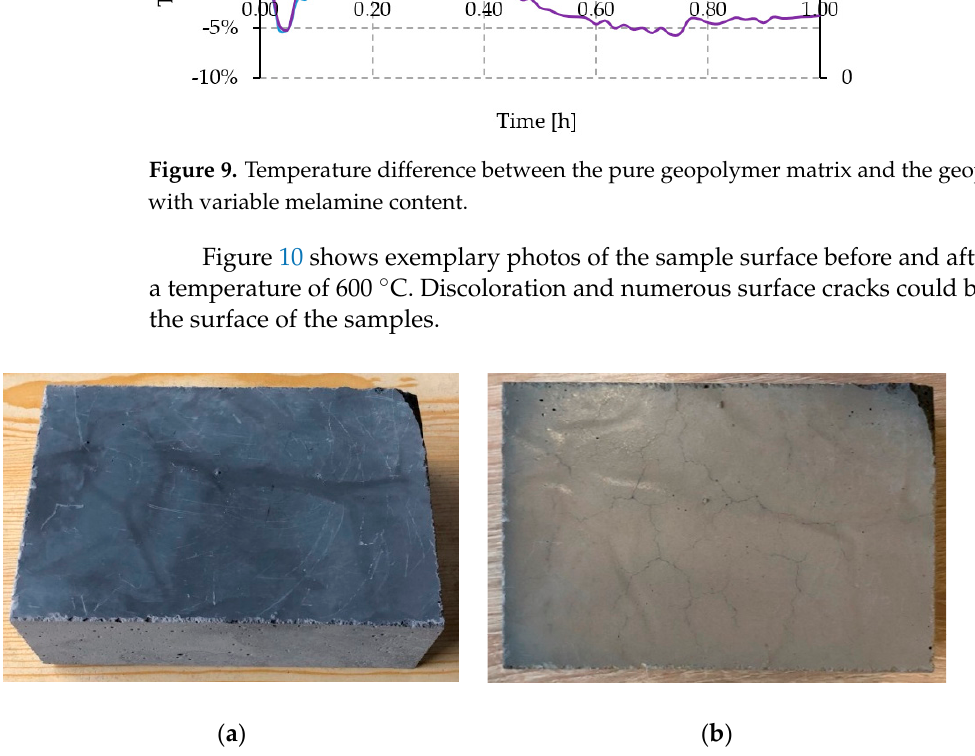
Figure 10. Exemplary photos of the sample surface before ( a ) and after ( b ) exposure to a temperature of 600 °C.